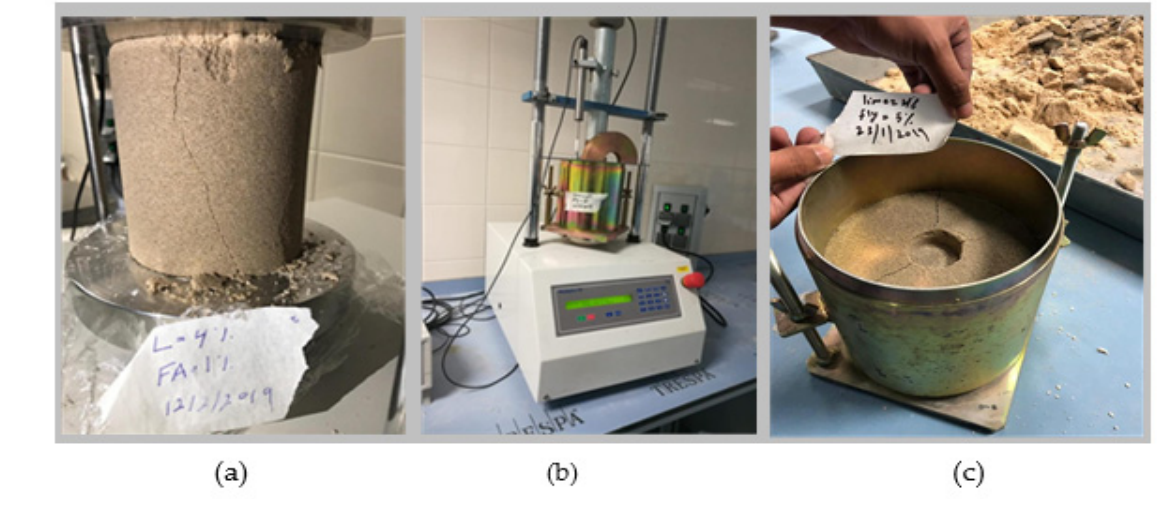
Figure 10. Unconfined compressive strength of the treated dune sand vs. different lime content.